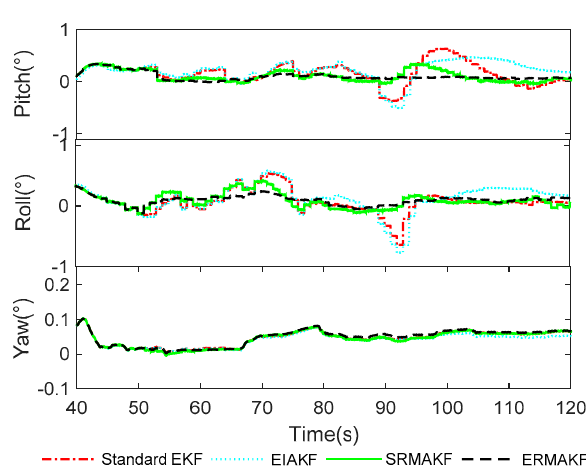
Figure 6. Attitude errors comparison.